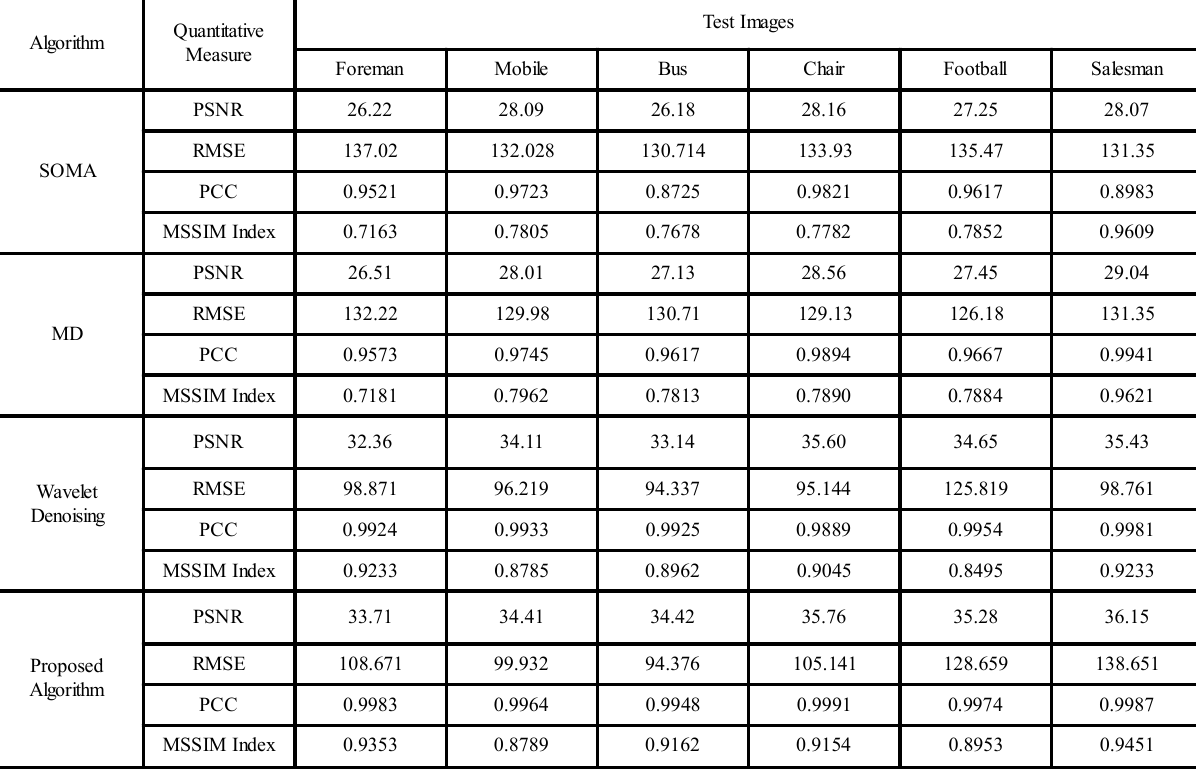
TABLE 3. QUANTITATIVE RESULTS OF PROPOSED ALGORITHM WITH OTHER TECHNIQUES WITH SPECKLE NOISE AND